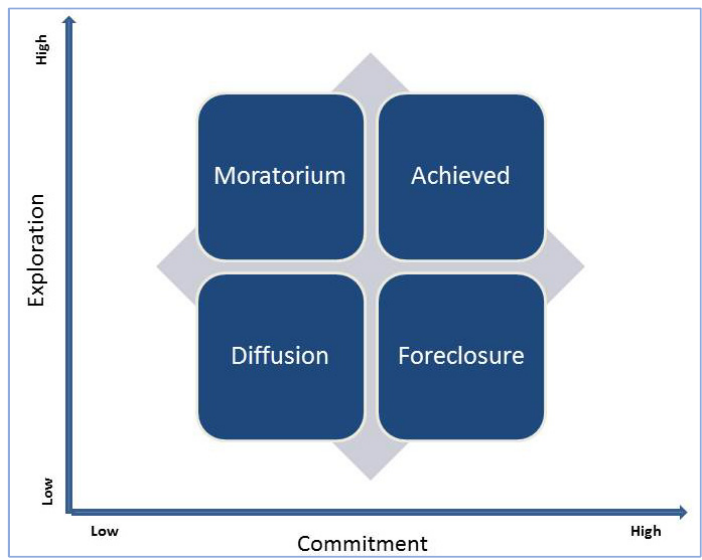
Figure1. Identity Status Model (Marcia,